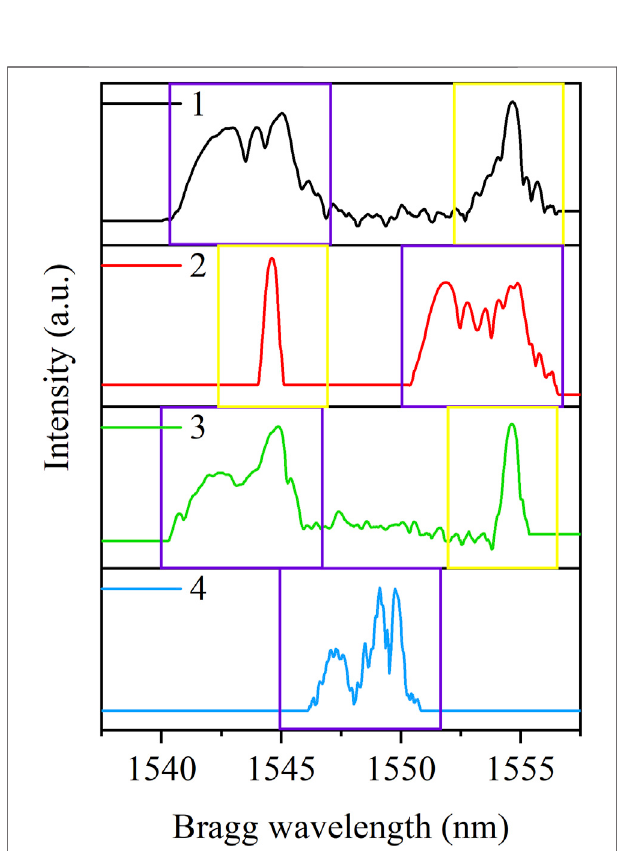
FIGURE 11 | Spectral characterization of the asymmetric deformation in glass-to-metal obtained by an interrogator.